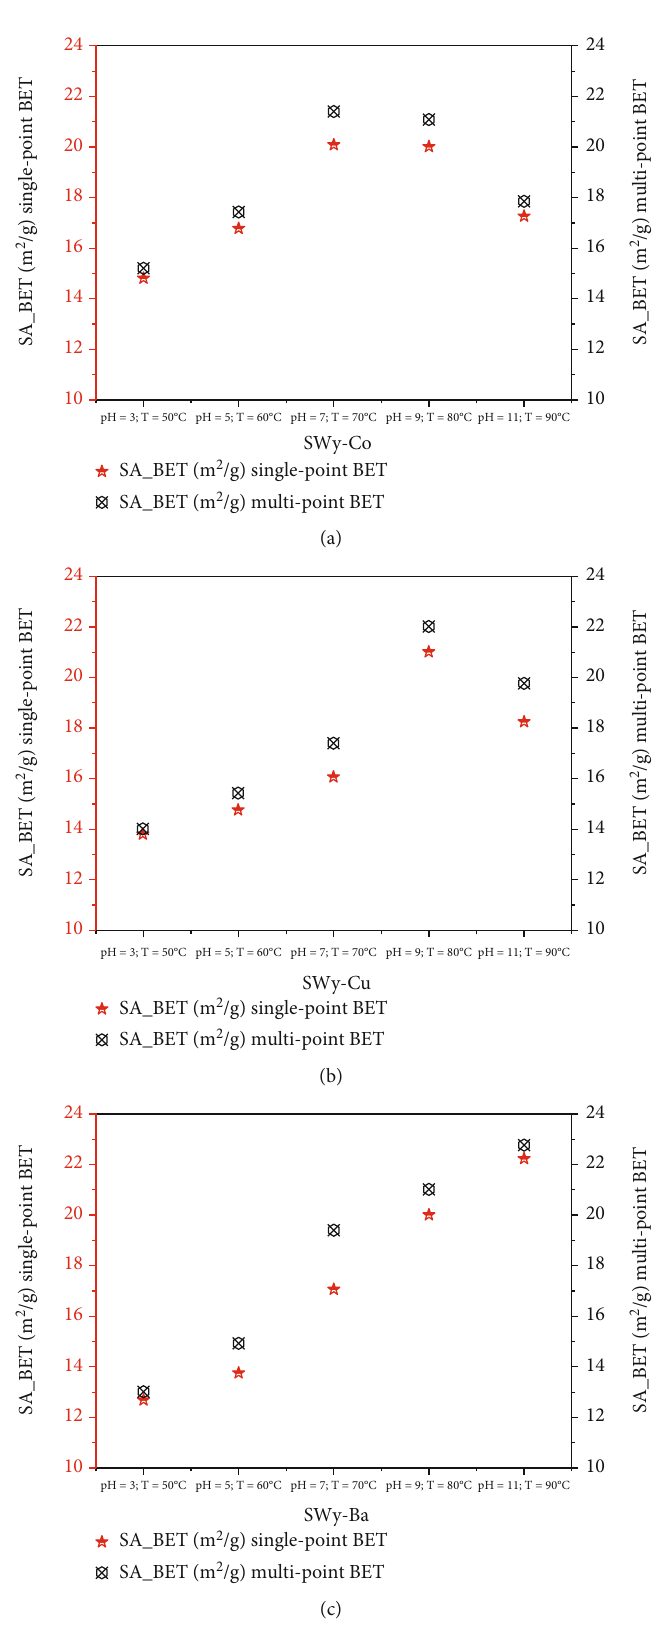
Figure 12: SA single and multipoint BET evolution versus constraint strength for (a) SWy-Co, (b) SWy-Cu, and (c) SWy-Ba BET